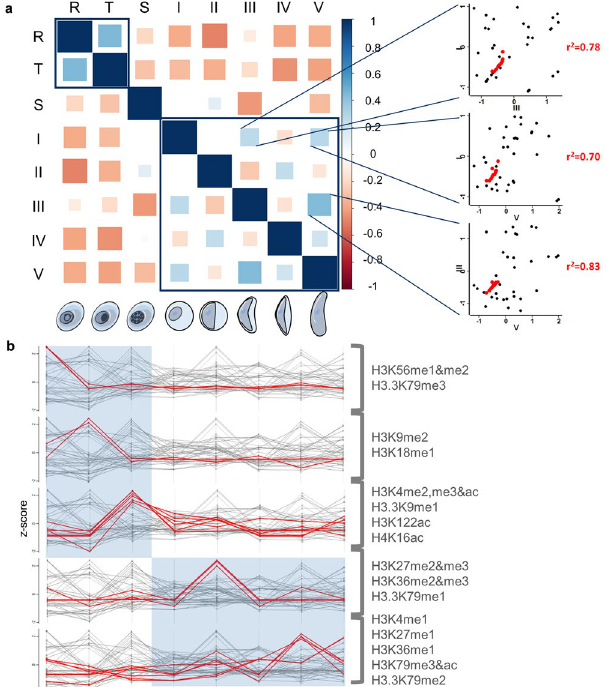
Figure 3. Dynamic patterns of histone PTMs between asexual and sexual development. ( a ) Correlation of the overall histone PTM landscape between the eight P. falciparum life cycle stages shows an early asexual cluster and a gametocyte cluster of correlating PTM landscapes (Pearson correlation). Correlation of a subset of 13 conserved residues (H3K4ac, H3K9me1, H3.3K9me2, H3K18me1, H3K23me1, H3K27me2&me3, H3K36me2&me3, H3K56me1&me2, H3K79me3 and H3.3K79me3) between stage I & III (r 2 = 0.78), I & V (r 2 = 0.70) and III & V (r 2 = 0.83) gametocytes are shown in red. ( b ) Stage-specific trends based on z-score distribution are shown for rings (H3K56me1&me2; H3.3K79me3), trophozoites (H3K9me2; H3K18me1), schizonts (H3K4me2, me3 & ac; H3.3K9me1; H3K122ac; H4K16ac) early gametocytes (H3K27me2 & me3; H3K36me2 & me3; H3.3K79me1) and late gametocytes (H3K4me1; H3K27me1; H3K36me1; H3K79ac & me3;